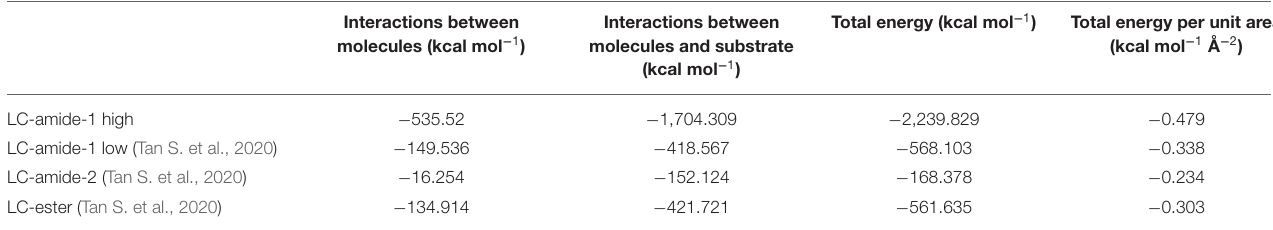
TABLE 2 | Total energies and energies per unit area of self-assemblies on the HOPG surface a